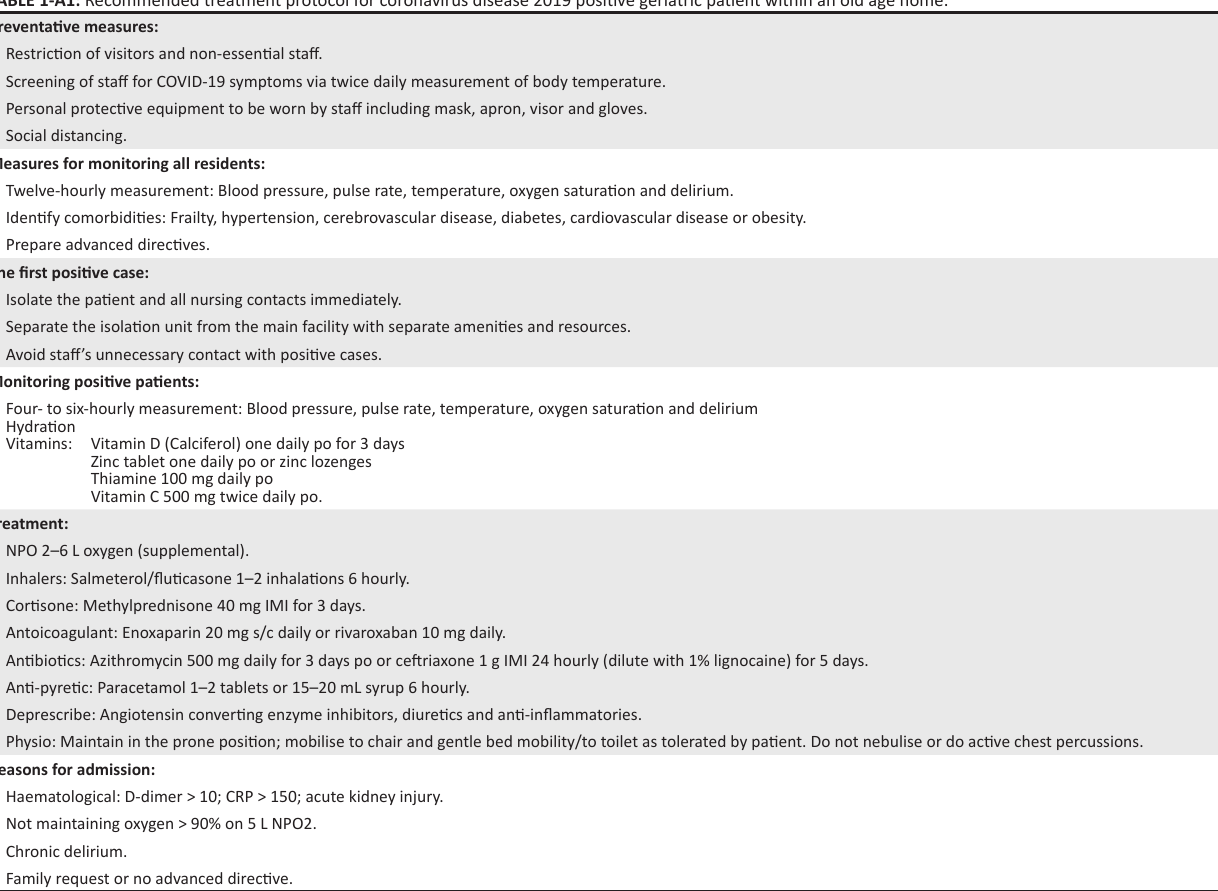
TABLE 1-A1: Recommended treatment protocol for coronavirus disease 2019 positive geriatric patient within an old age home. Preventative